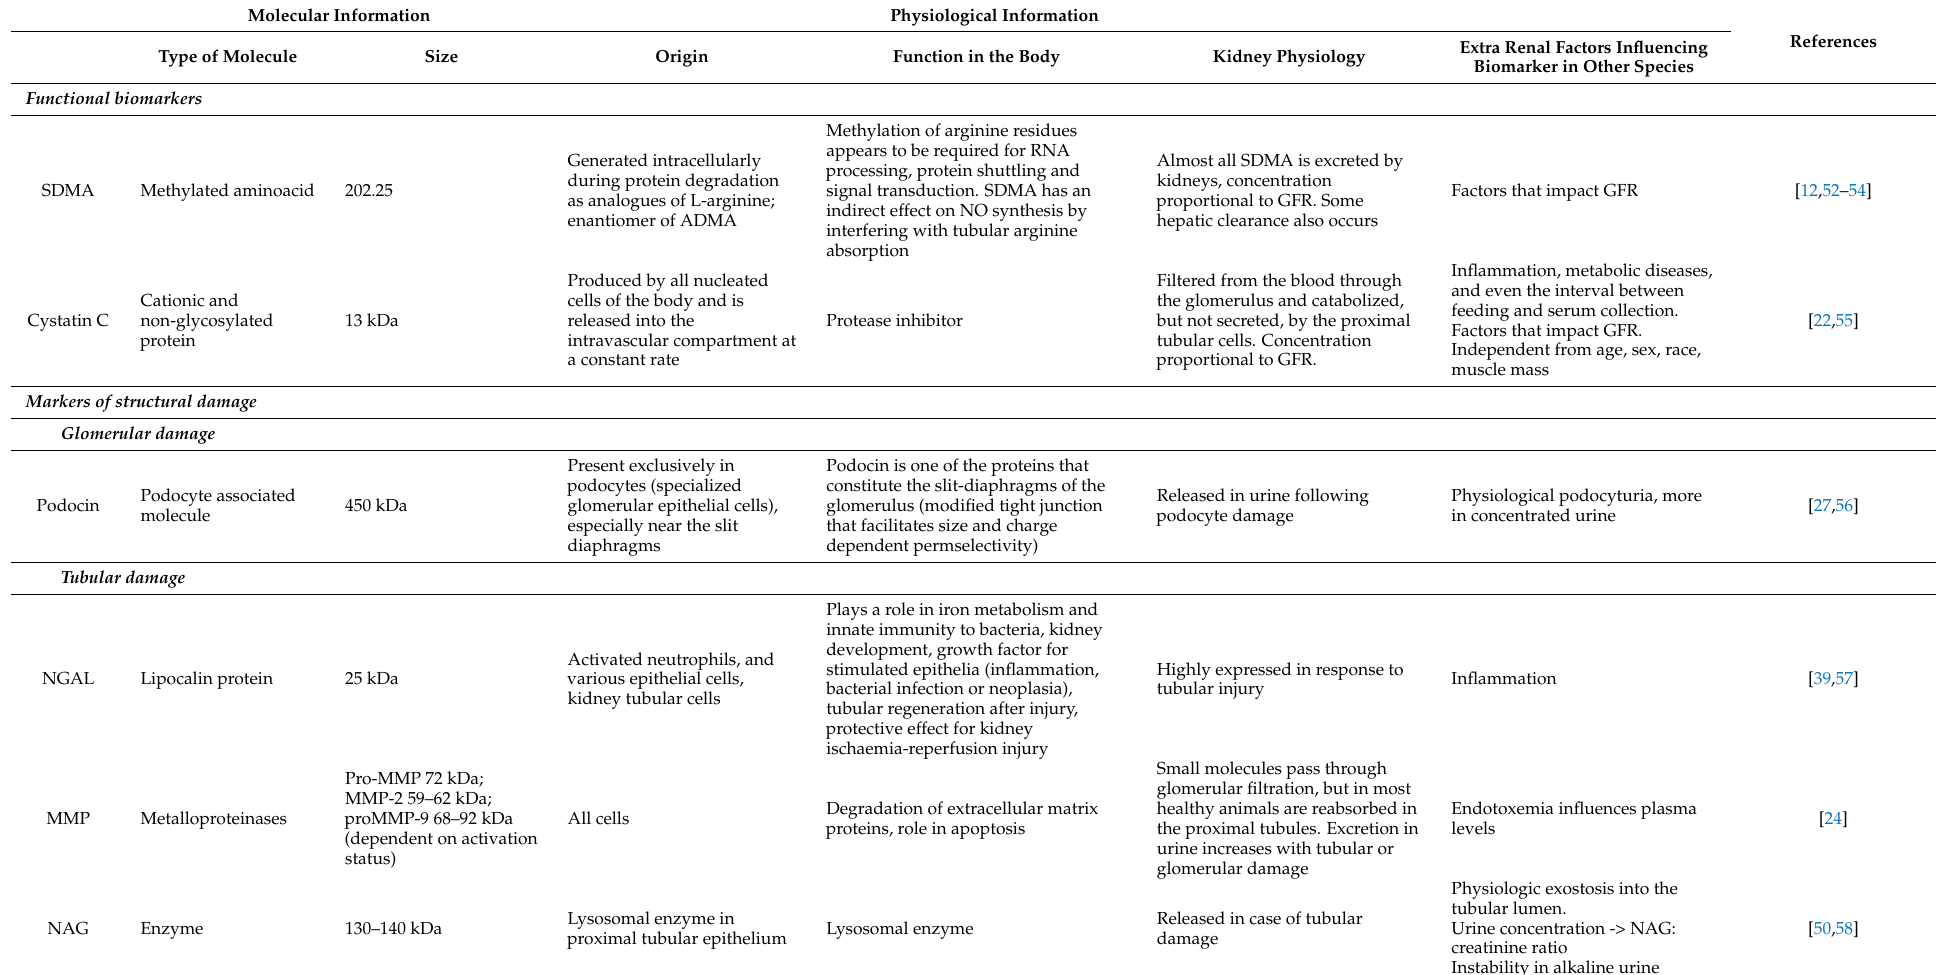
Table 6. Overview of molecular and physiological information on the identified kidney